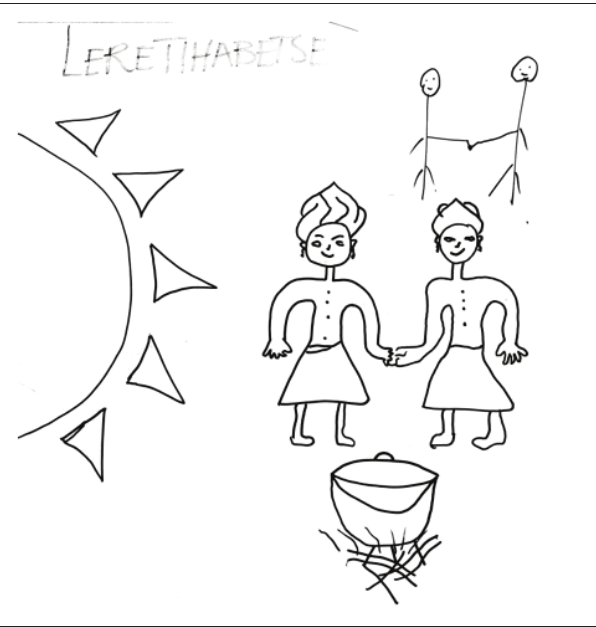
FIGURE 1: Sekhing focus group